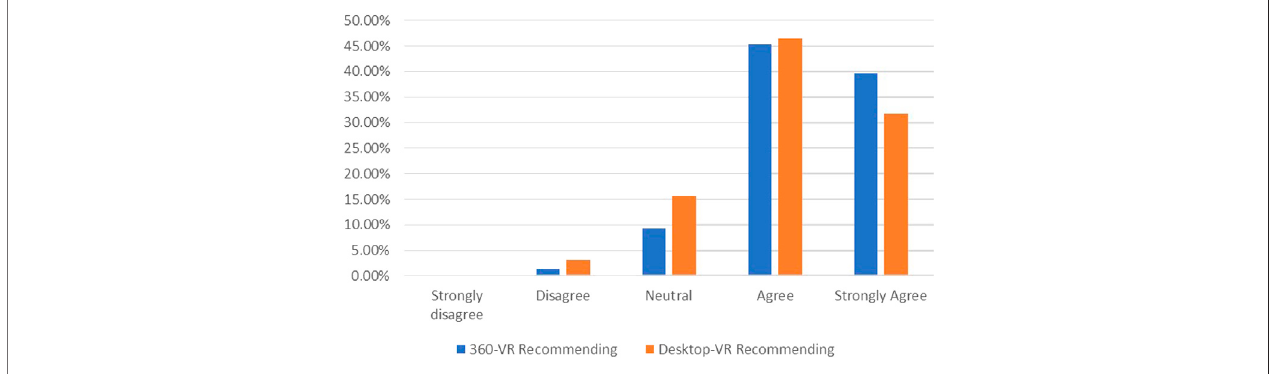
FIGURE 6 | The % of people who would recommend VR training (either desktop-VR or 360-VR)